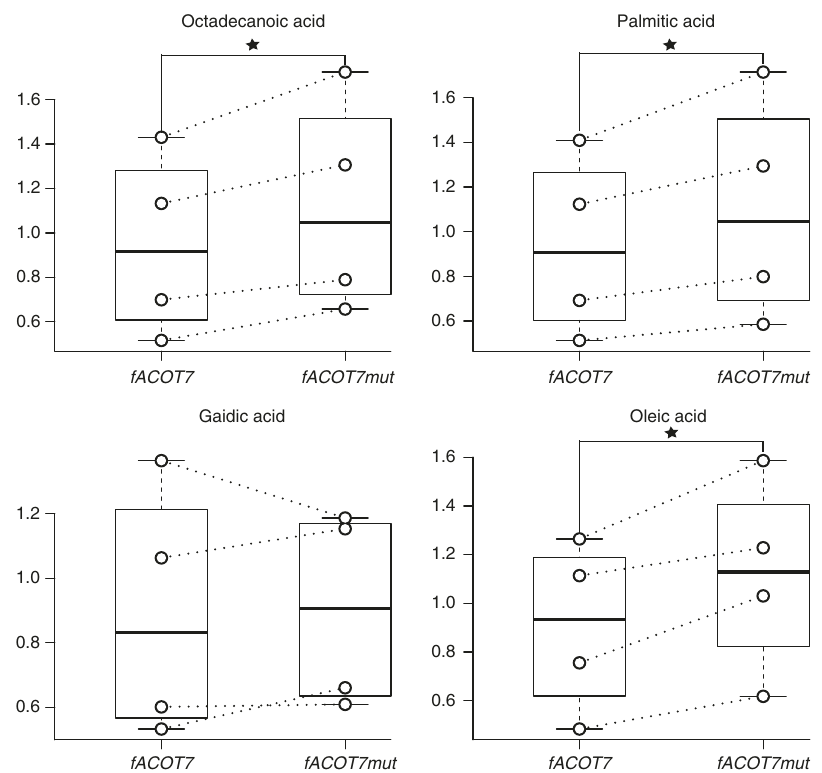
Fig. 3 Functional validation of ACOT7 GCG197GTG substitution. The abundances of free fatty acids were measured using GC – MS in the mouse adipocyte cells expressed with ACOT7 wild type ( fACOT7 ) and ACOT7 mutant type ( fACOT7mut ), respectively. For each free fatty acid, the abundance was compared between wild and mutant types and the median, fi rst and third quartiles were shown in the box (middle bar represents median, upper bound the third quartile, lower bound the fi rst quartile). Four independent experiments were performed. * P < 0.05 by the paired t test. Source data are provided as a Source Data fi